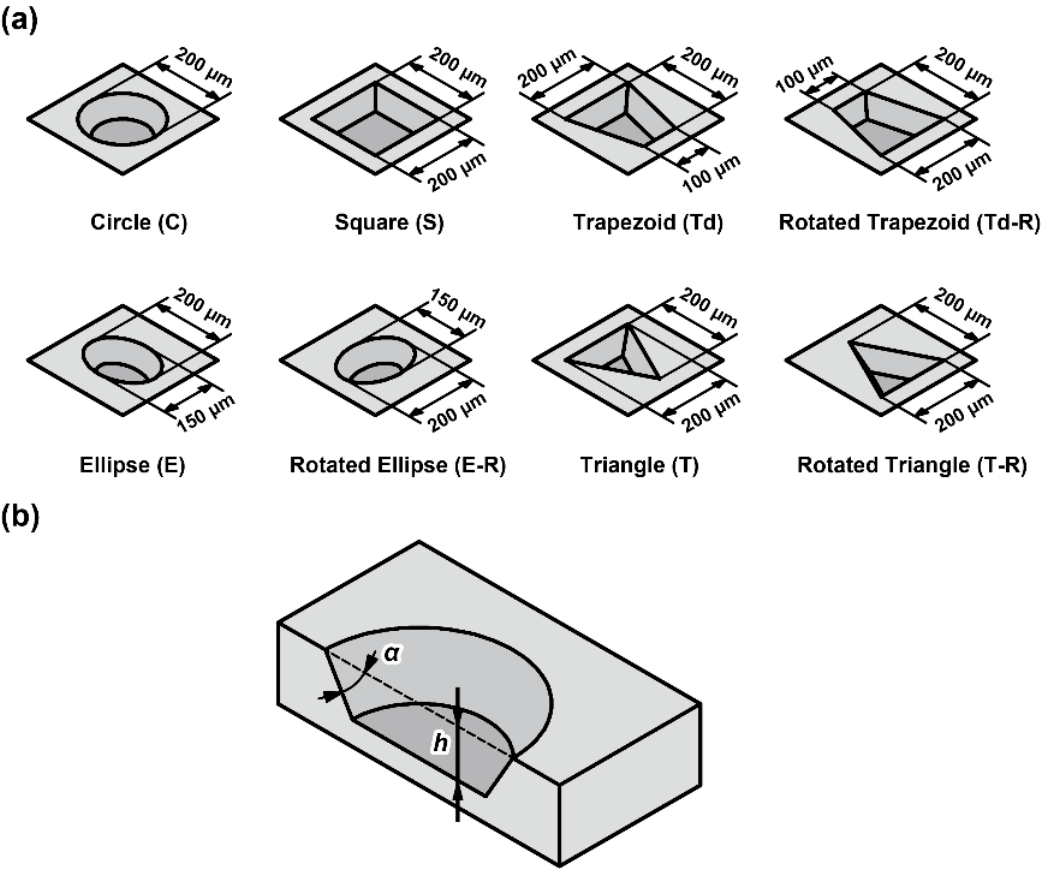
Figure 4. ( a ) Designs of the dimples with di ff erent shapes and ( b ) the definition of dimple surface angle α and dimple depth h